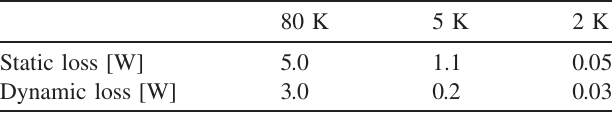
TABLE III. Calculated static and dynamic thermal losses of input coupler. (The outer conductor at the cold part consists of 1- mm thick stainless steel and 5 - (cid:1) m thick copper plating.)